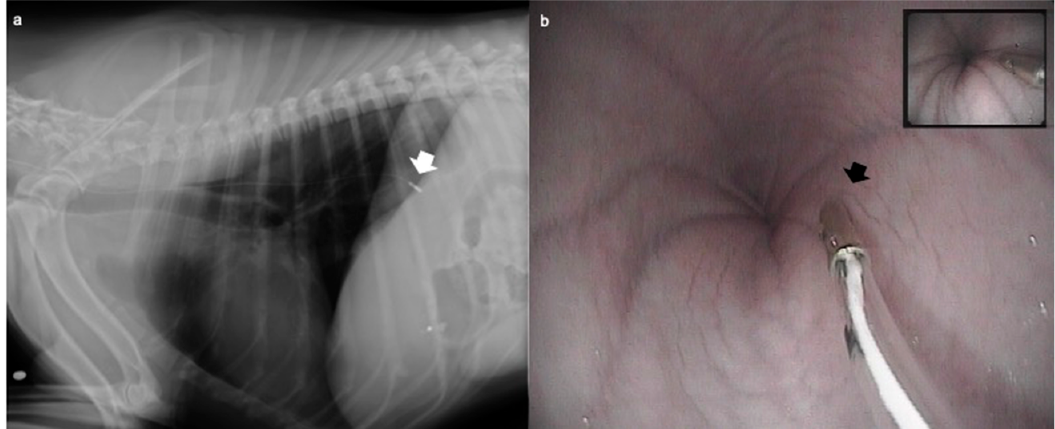
Figure 1. The correct placement of the oesophageal probe was confirmed by ( a ) fluoroscopy in the dogs undergoing orthopaedic surgery (ORT group) or ( b ) by endoscopy in the dogs undergoing an endoscopic examination ( n = 12) (END group). After intubation, the probe was placed in the oesophagus up to a length previously measured externally and determined to be equal to the distance between the incisor tooth and the cranial border of the 10th rib.